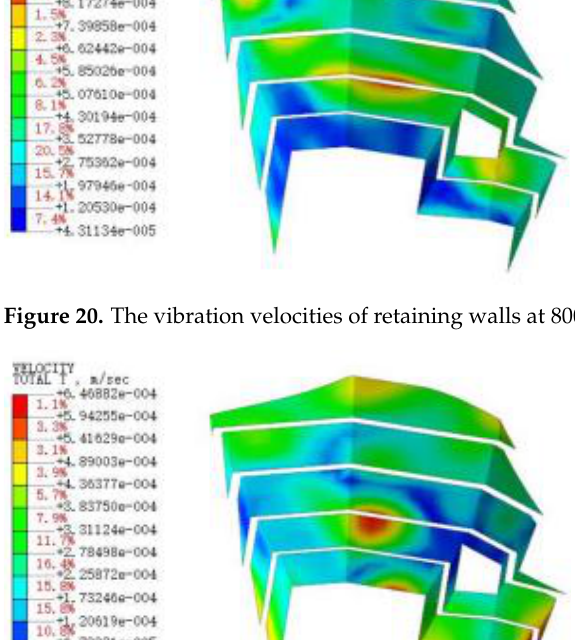
Figure 19. The vibration velocities of retaining walls at 500 ms.